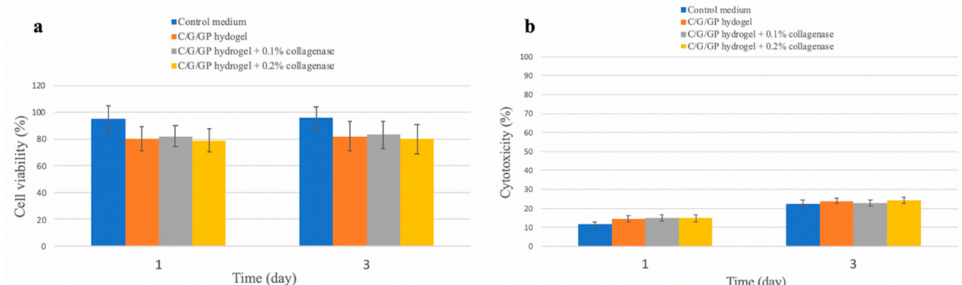
Figure 2. Cytotoxic of chitosan / gelatin / β -glycerol phosphate (C / G / GP) with collagenase to